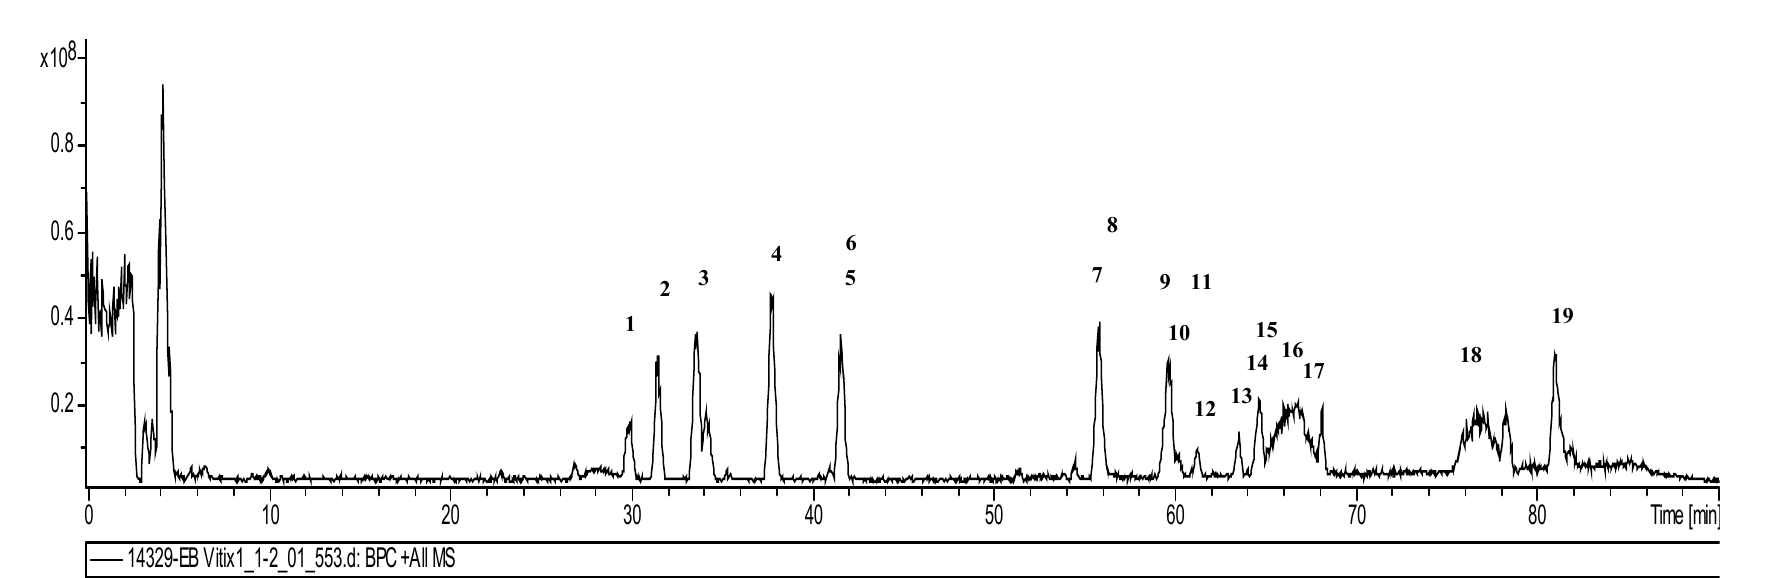
Figure 2. Base peak chromatogram (BPC) of the crude Vitis vinifera L. extract in positive mode with procyanidins (dimer and trimer) and the identified flavonoids.